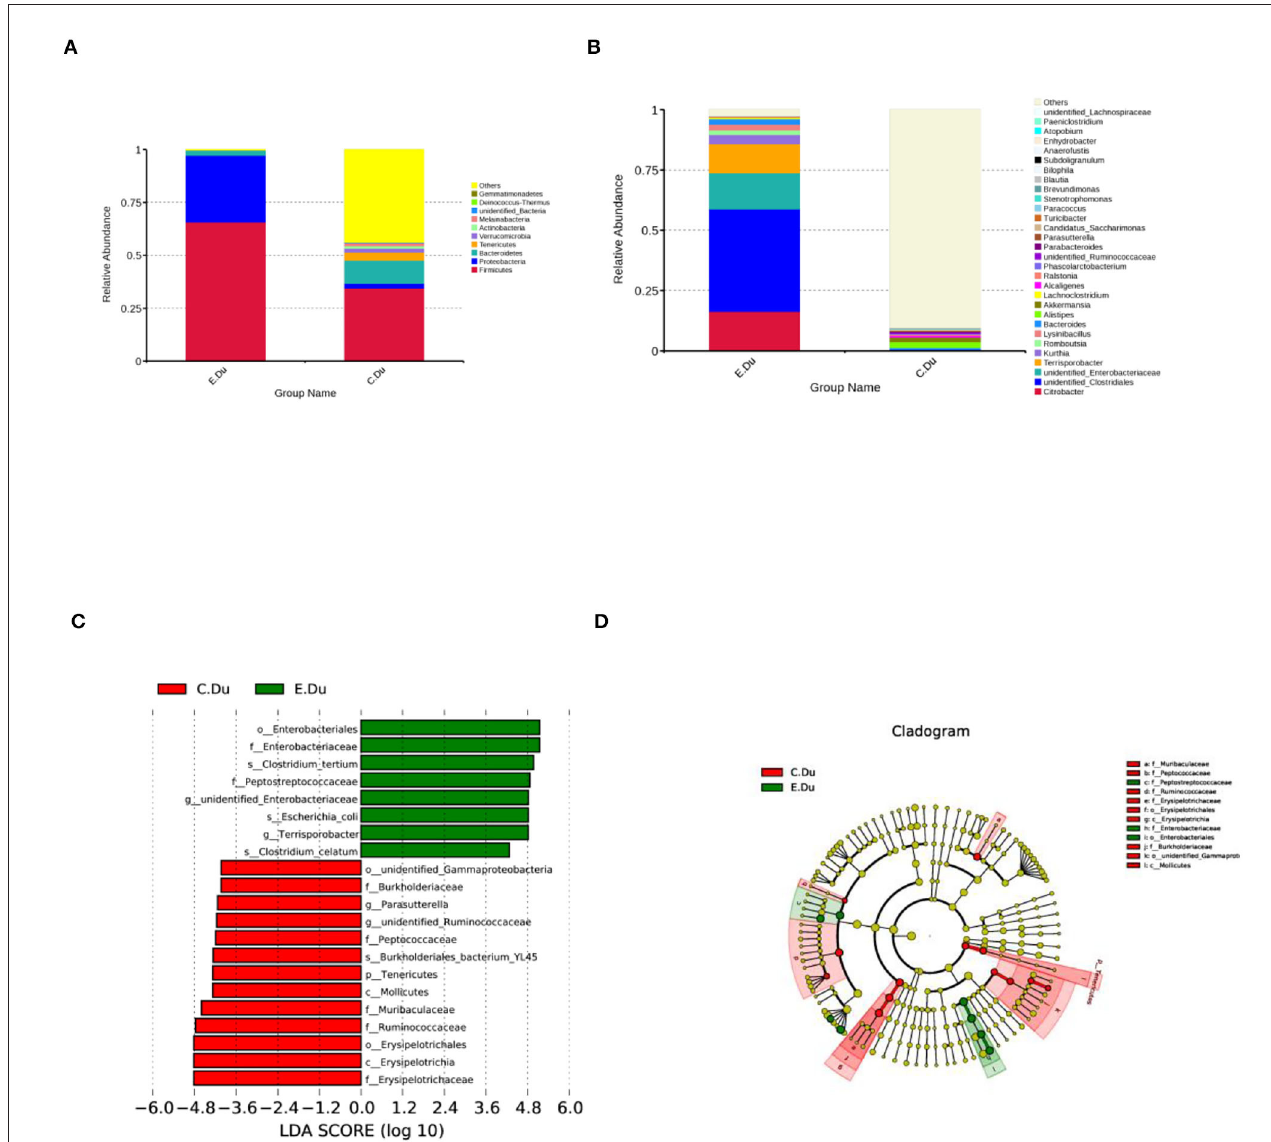
FIGURE 3 | Gut microbiota composition profiles in healthy and diarrhea rabbits. (A) Summary of the relative abundances of bacterial genera detected in healthy and diarrhea rabbits. (B) Genus-level bacteria were significantly different between the healthy and diarrhea rabbits. Data were shown as relative abundance (%) of the top 10 most abundant genera in each group. Statistical analysis was performed by the Wilcoxon rank-sum test. (C) Cladogram generated from the LEfSe analysis indicating the phylogenetic distribution from phylum to genus levels of the microbiota of healthy and diarrhea rabbits. (D) Histogram of LDA scores to identify differentially abundant bacterial genera between healthy and diarrhea rabbits (LDA score ≥